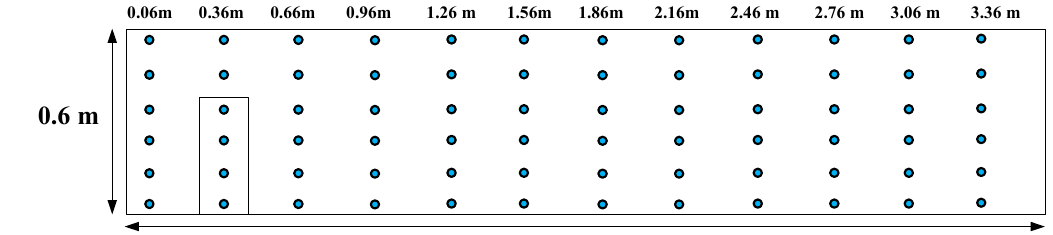
Figure 3. Arrangement of the thermocouples.